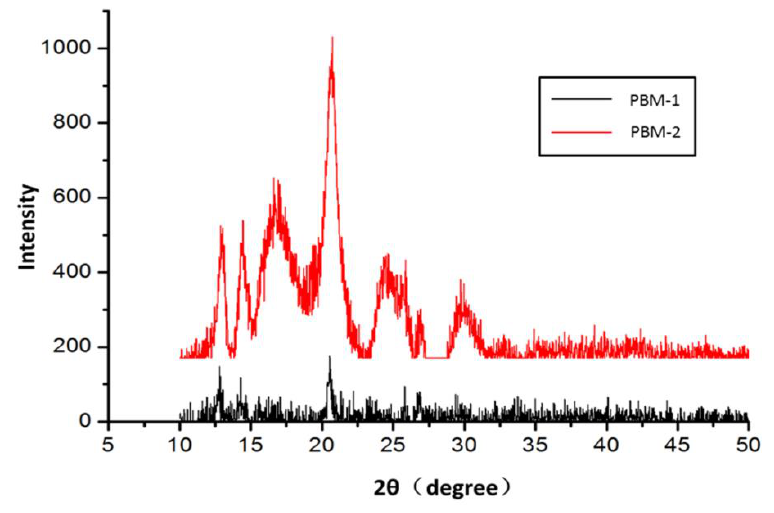
Figure 4. X-ray diffraction spectrum of PBM.